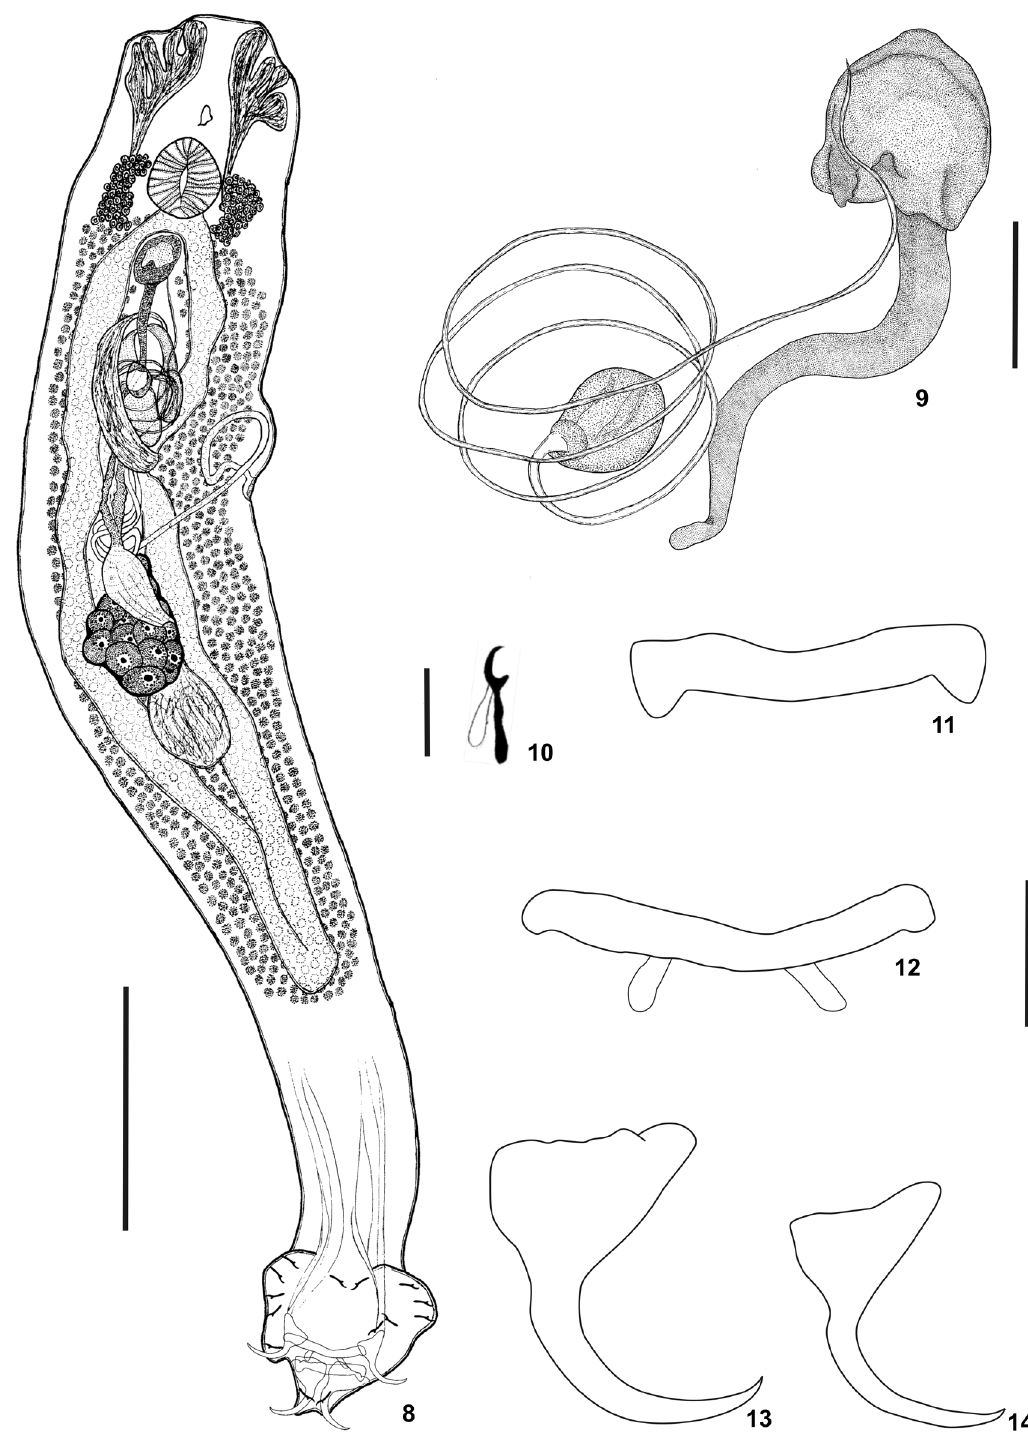
Figures 8–14. Cosmetocleithrum leandroi sp. nov.: (8) holotype whole-mount, ventral; (9) copulatory complex; (10) hook; (11) ventral bar; (12) dorsal bar; (13) ventral anchor; (14) dorsal anchor. Scale bars: 8 = 100 μm; 9, 11–14 = 25 μm; 10 = 10